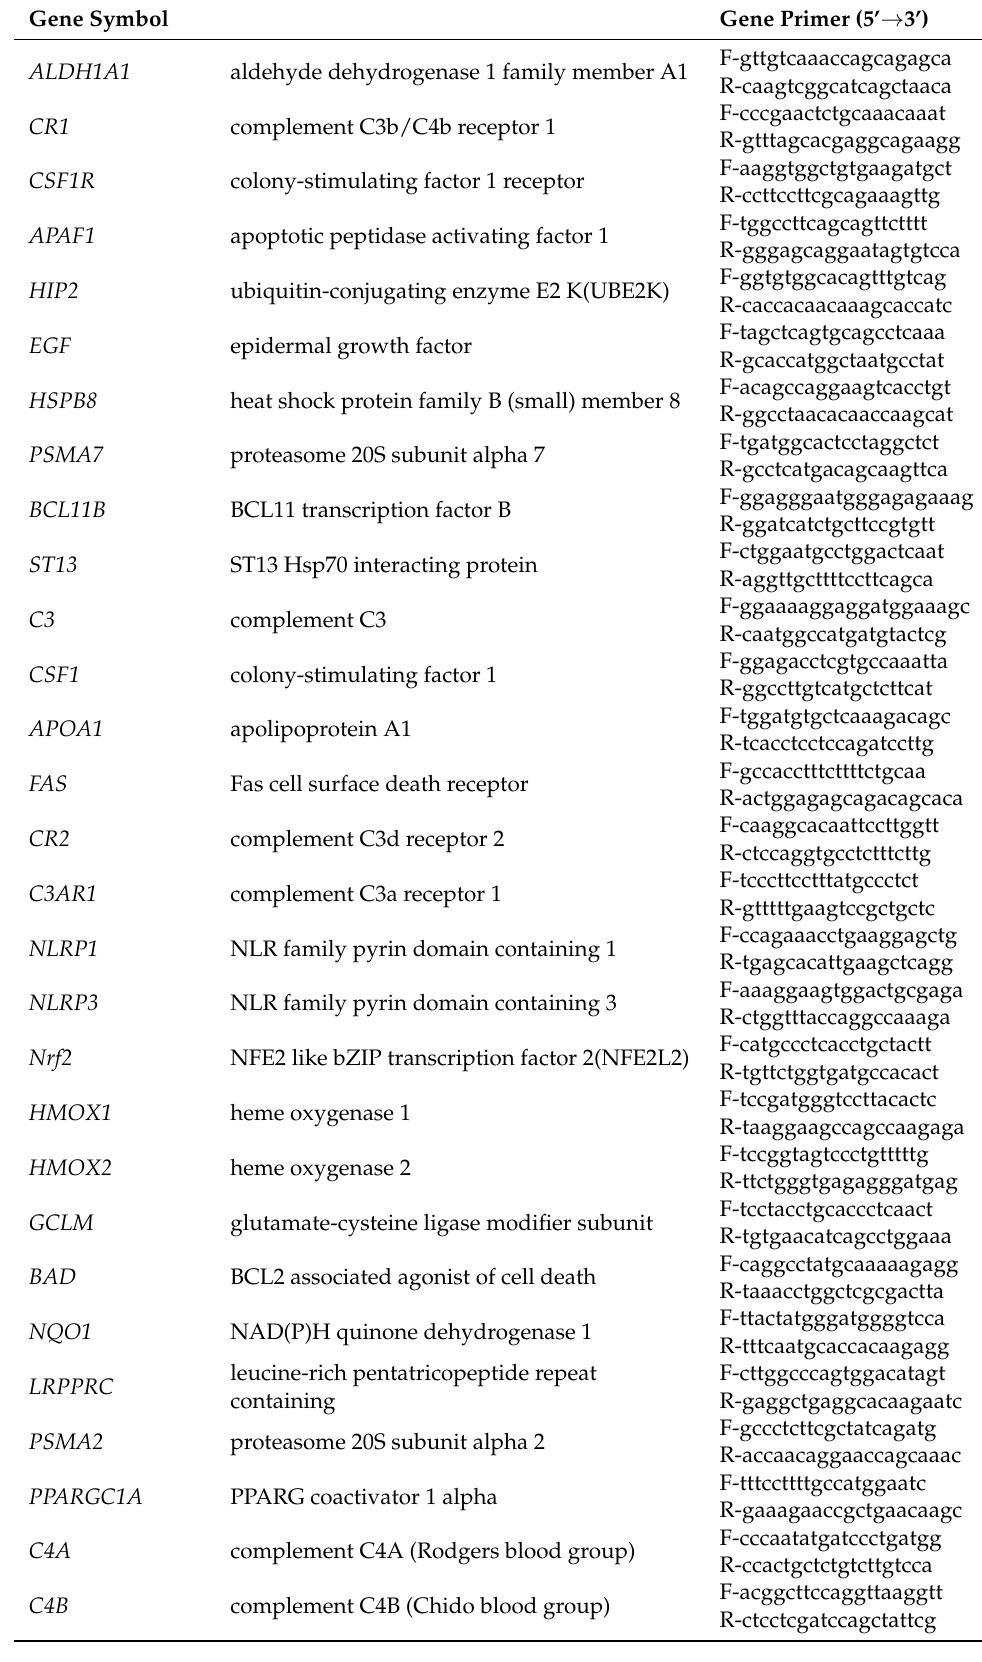
Table 4. Genes and primers of q-PCR array related to oxidative stress and